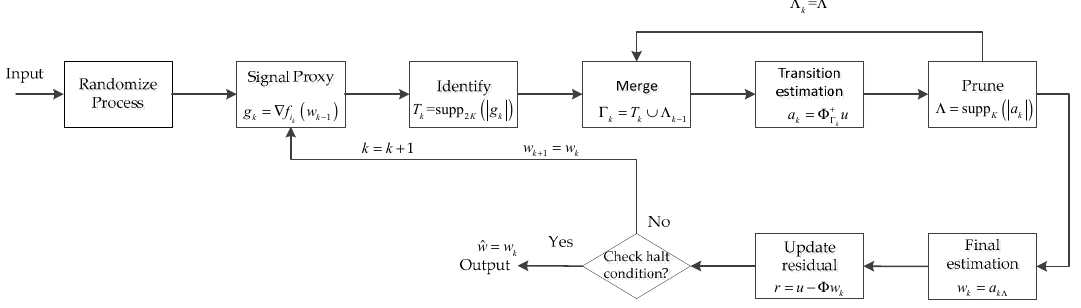
Figure 1. Block diagram of the StoGradMP algorithm.